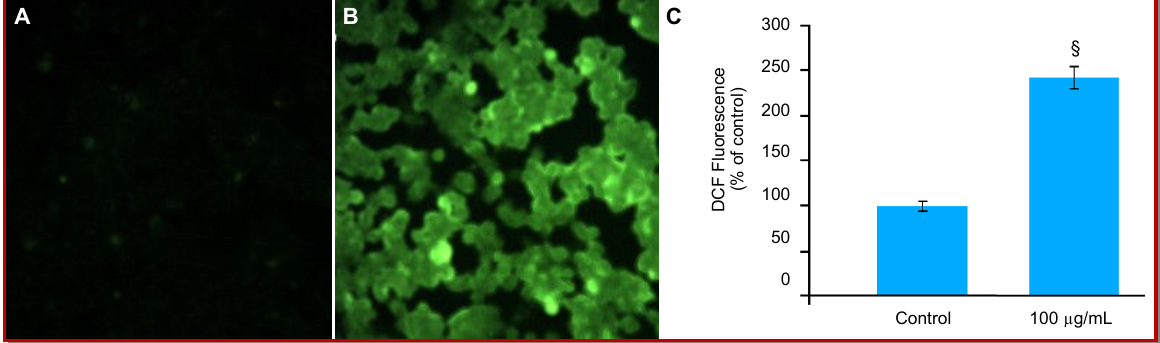
Figure 2: The fluorescence gradient in control (A) and Z. decandra- treated cells (B). Levels of intracellular ROS were determined using DCF-DA (C), which is membrane present and acted on by esterase to DCF which reacts to give fluorescence. Fluorescence intensity was measured using spectroflurometer at 485 and 530 nm. Results are represented as average values of three independ- ent experiments; § indicates statistical significance (p<0.05)